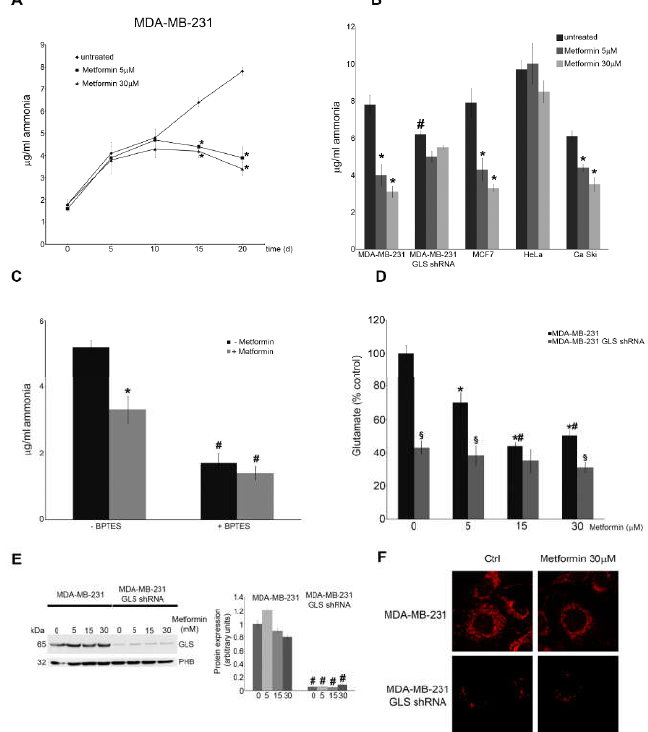
Figure 3. Metformin reduces ammonia and glutamate accumulation by inhibiting glutaminase; ( A ) MDA-MB-231 cells were either left untreated or treated with 5 or 30 μM metformin for the time indicated. Ammonia level in the culture medium was measured as indicated in the Material and Methods section; ( B ) MDA-MB-231, MDA-MB-231 GLS shRNA, MCF7, HeLa and Ca Ski cells were either left untreated or treated with 5 or 30 μM metformin for 20 days. Ammonia level in the culture medium was measured as indicated in the Material and Methods section. # Significantly